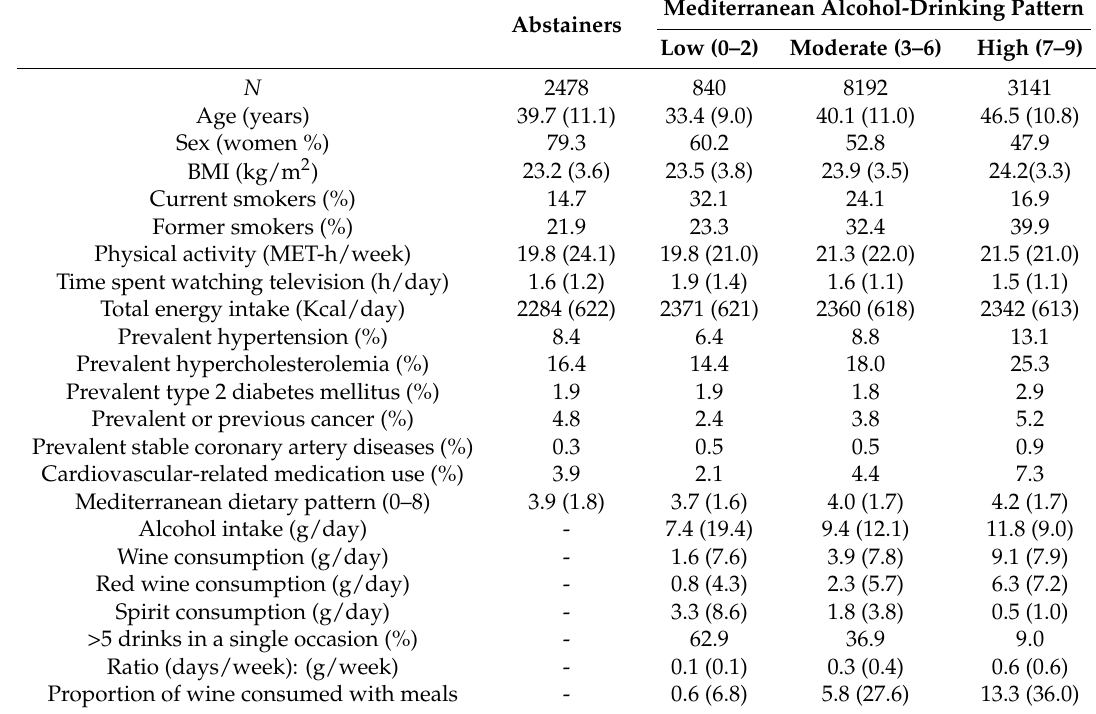
Table 1. Baseline characteristics of participants (mean (standard deviation) or %) according to adherence to the Mediterranean alcohol-drinking pattern. The Seguimiento Universidad de Navarra (University of Navarra follow-up) (SUN) project